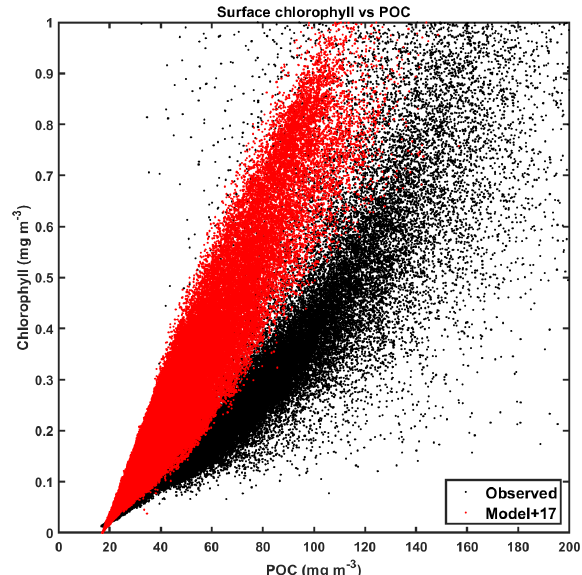
Figure 18. Climatological surface particulate organic carbon (POC) vs. chlorophyll for CanESM5-CanOE (red) and observa- tions (black). Data are for all ocean grid points (2 × 2 ◦ uniform global grid) for all months of the year where observational data are available. Model POC is offset 17mgm − 3 for illustrative pur- poses. Chlorophyll concentrations > 1mgm − 3 are excluded as they largely represent coastal areas poorly resolved by coarse-resolution global ocean